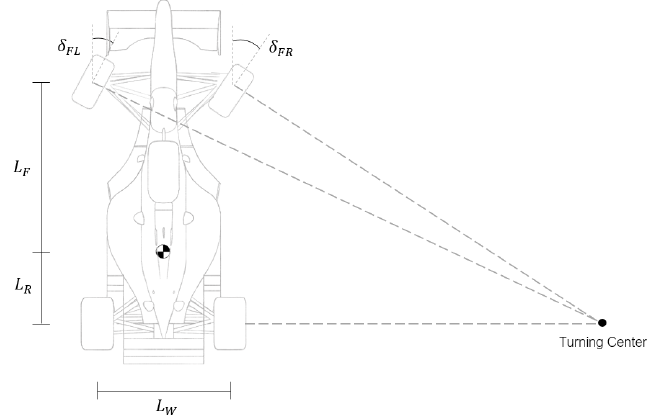
Figure 2. Ackermann steering ( δ FL < δ FR )